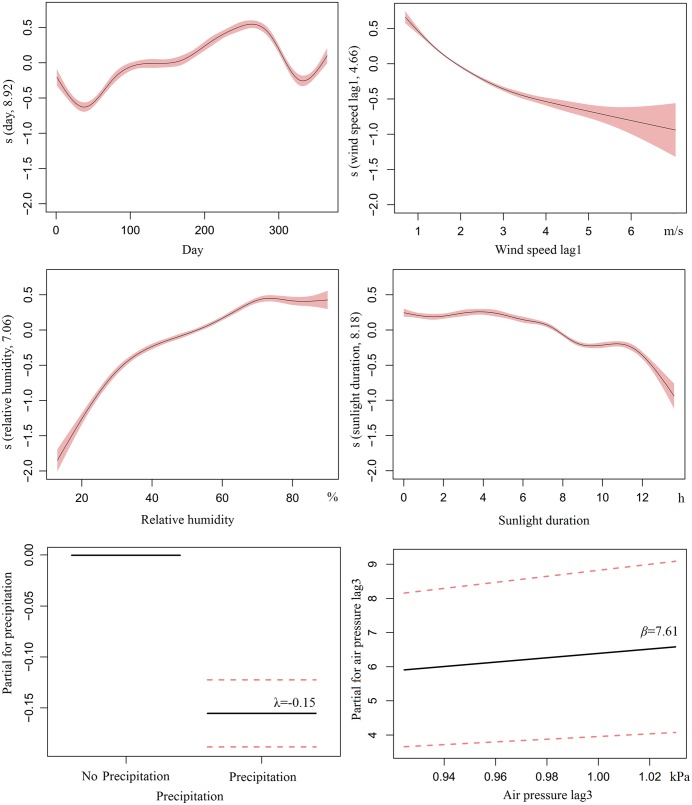
Exposure-response curves for PM2.5 and meteorological variables, Beijing, 2013–2014.